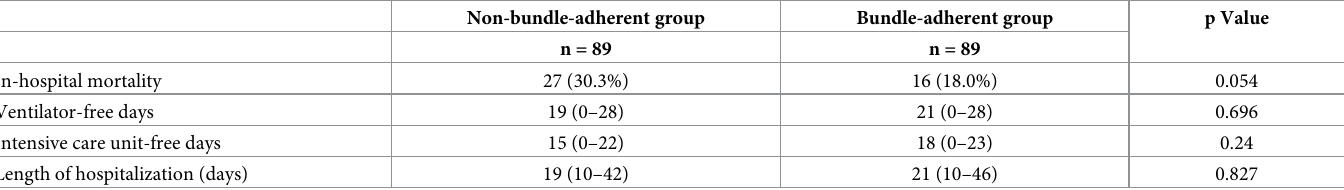
Table 2. Primary and secondary outcomes in the two